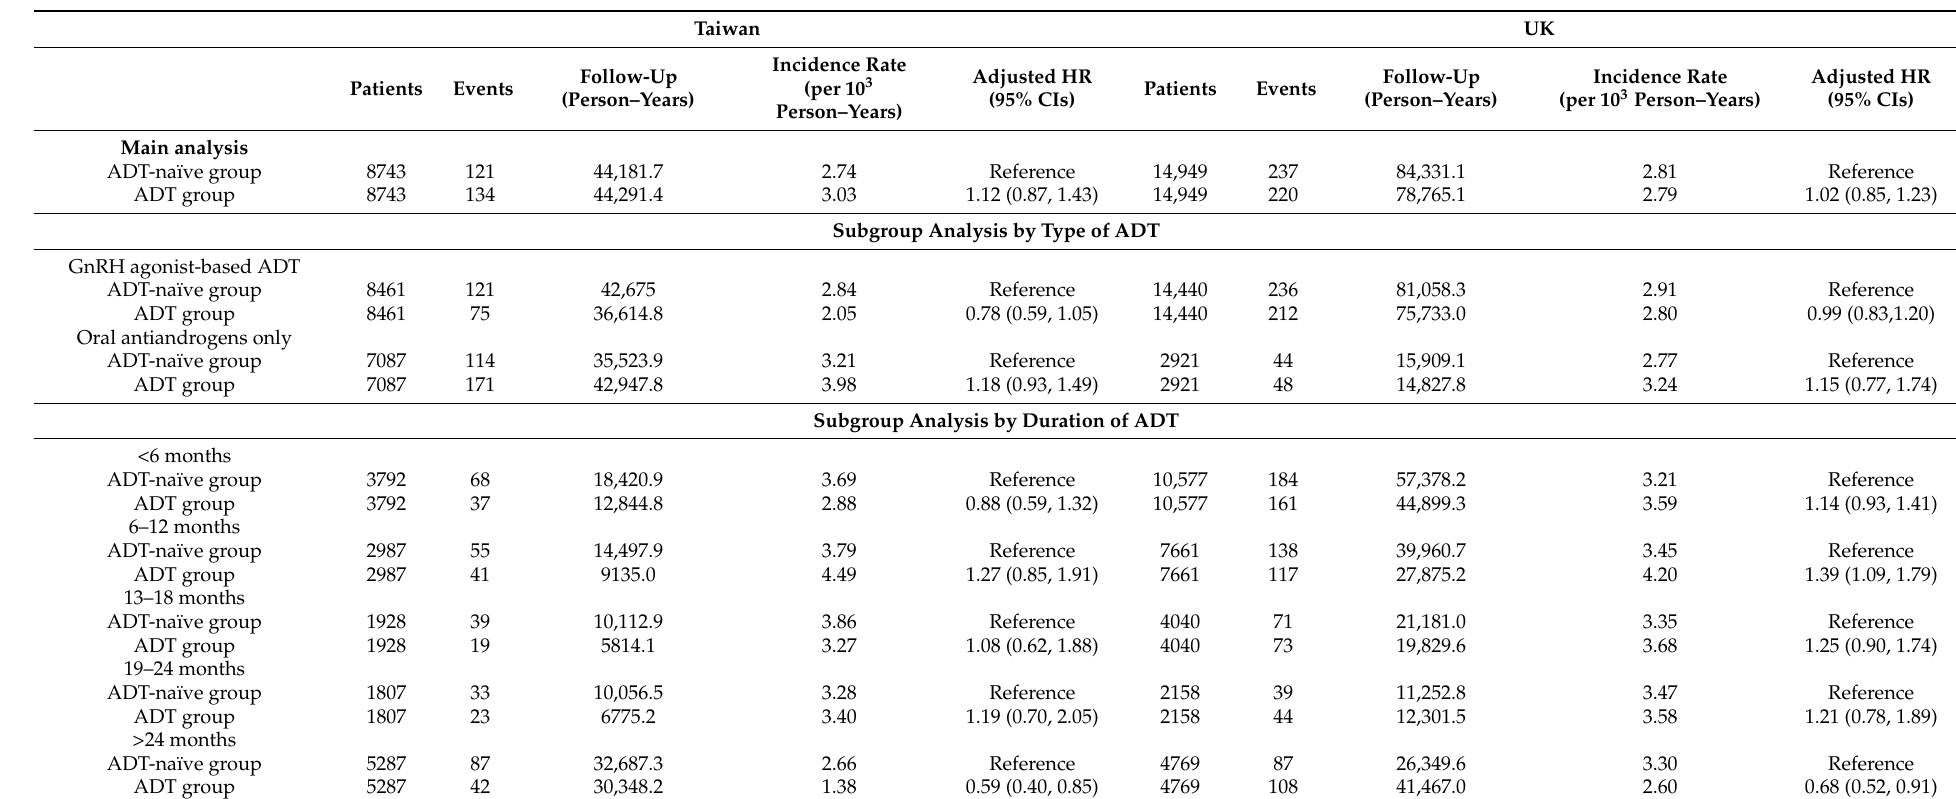
Table 2. Evaluation of the association between androgen deprivation therapy and the incidence of dementia. Taiwan